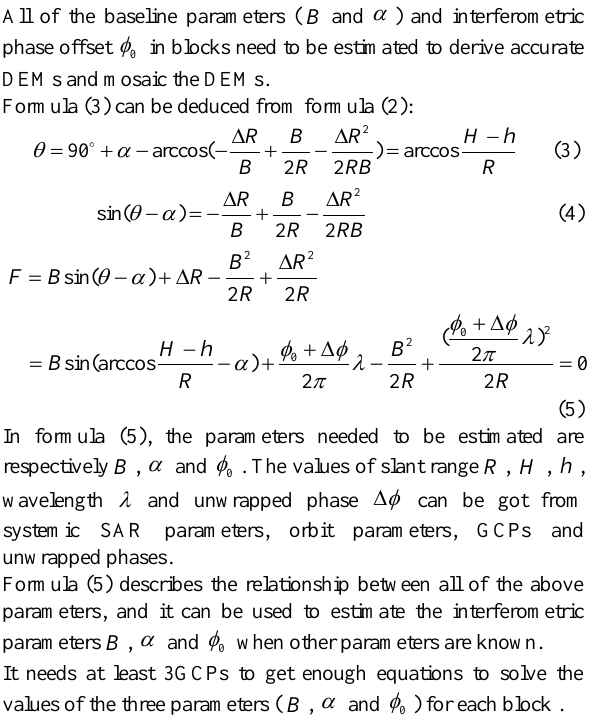
 ) for each block . 0